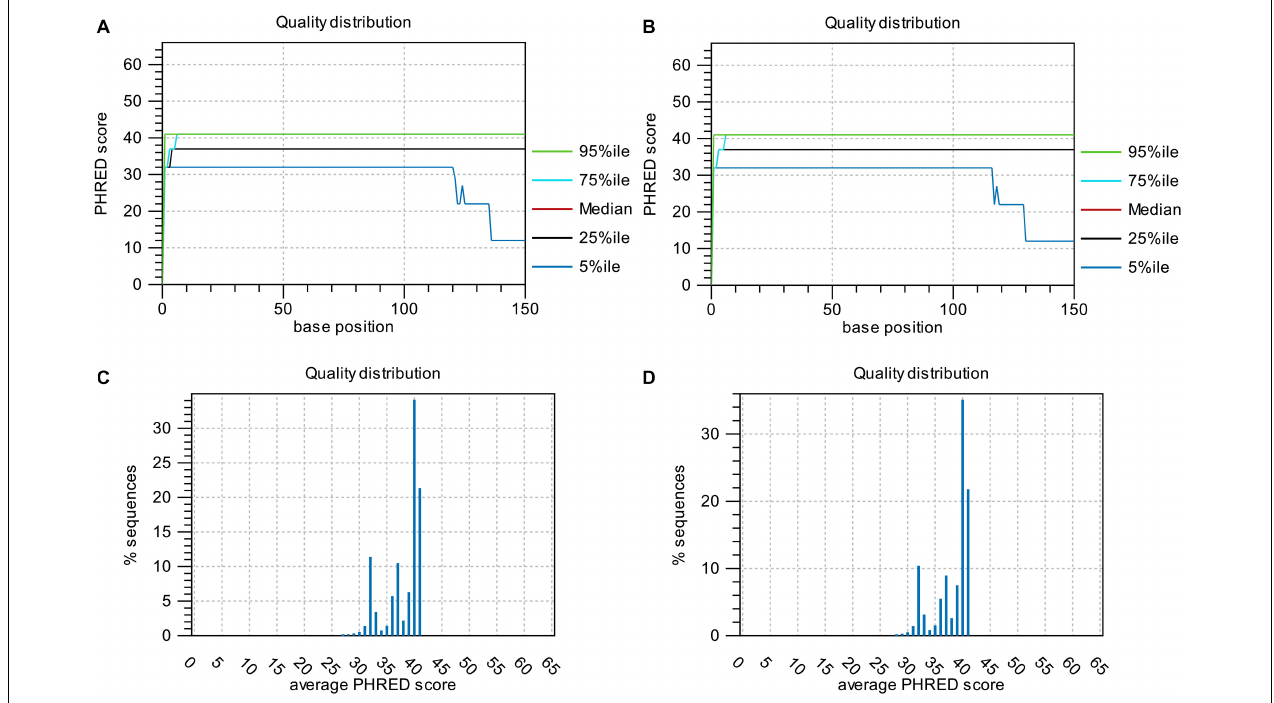
FIGURE 3 | Base-quality distribution along the base positions for sequences of strains following passage under selection pressure from gentamicin (A) and following subsequent passage in the absence of gentamicin (B) . PHRED scores present the median and percentiles of quality scores observed at different base positions. Distribution of average sequence quality scores for sequences of strains following passage under selection pressure from gentamicin and following subsequent passage in the absence of gentamicin is presented in panels (C,D) , respectively. The quality of a sequence is calculated as the arithmetic mean of its base qualities. The sequences observed at different quality scores are normalized to the total number of sequences. The figures were generated using CLC Genomics Workbench 11.0.1.